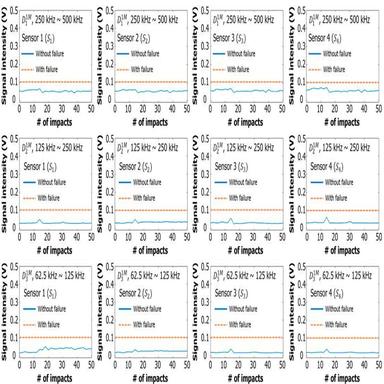
Damage analysis results for the composite laminates subjected to repetitive low-energy impact loading: a comparison of the intensities of the failure modespecific frequency band signal components.